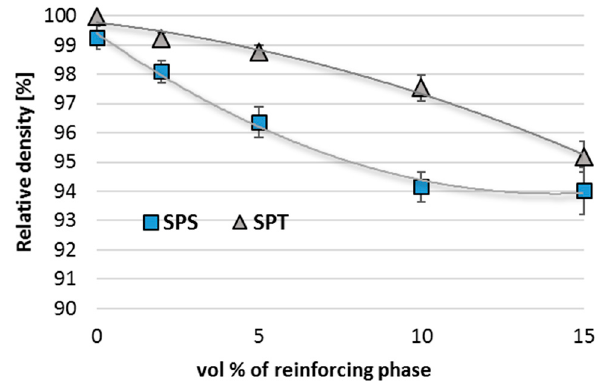
Figure 10. Relative density of AA6061/MLG composites obtain in SPS and SPT process.